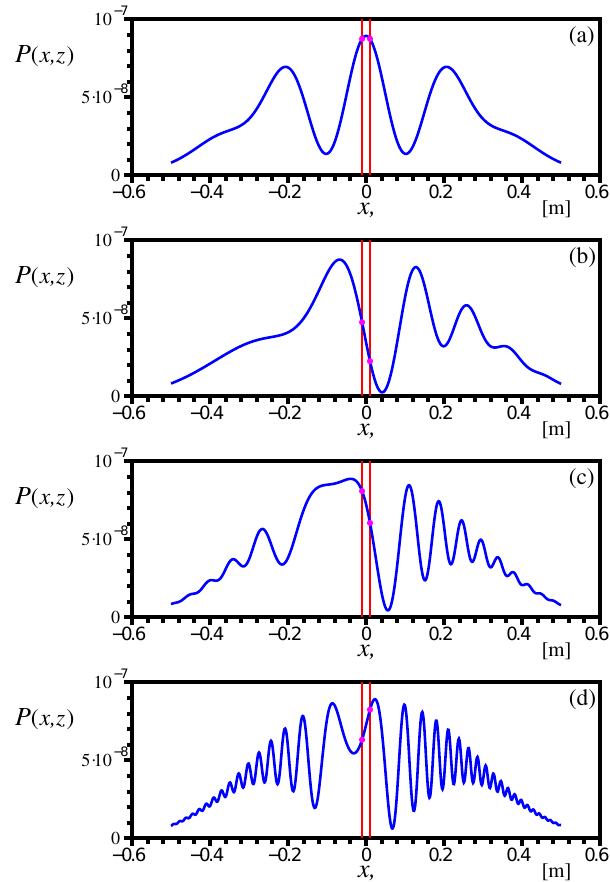
Figure 19. Interference fringes (blue curves) written at the distance of z = 20 m from the opaque screen, see Figure 16 at different values of δ : ( a ) δ = 0; ( b ) δ = 10 − 7 ; ( c ) δ = 4 · 10 − 7 ; ( d ) δ = 10 − 6 . Red lines show positions of detectors at x D = ± 0.01 m; Pink dots on intersection of blue curves and red lines are detector registered